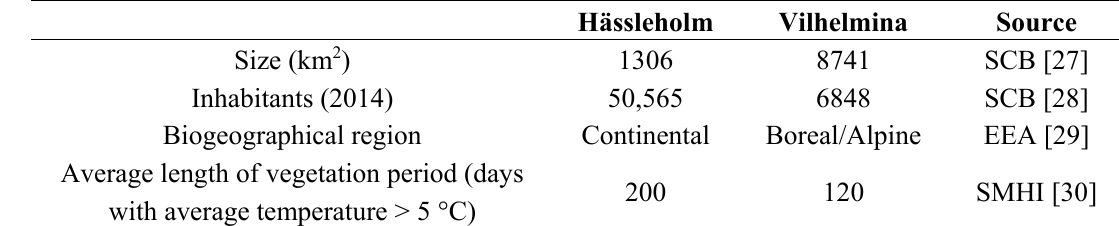
Table 1. Key facts about Hässleholm and Vilhelmina.